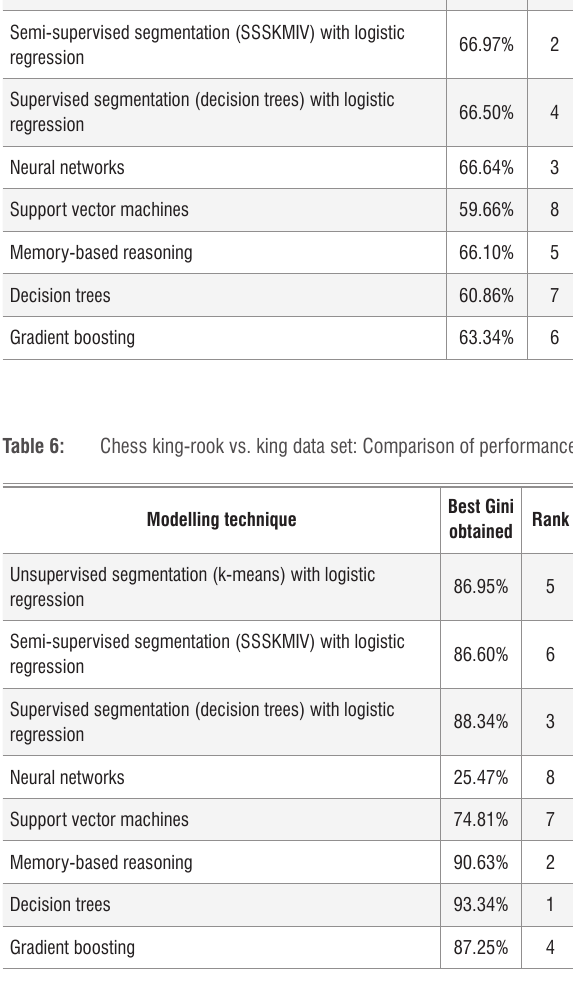
Best Gini Rank obtained